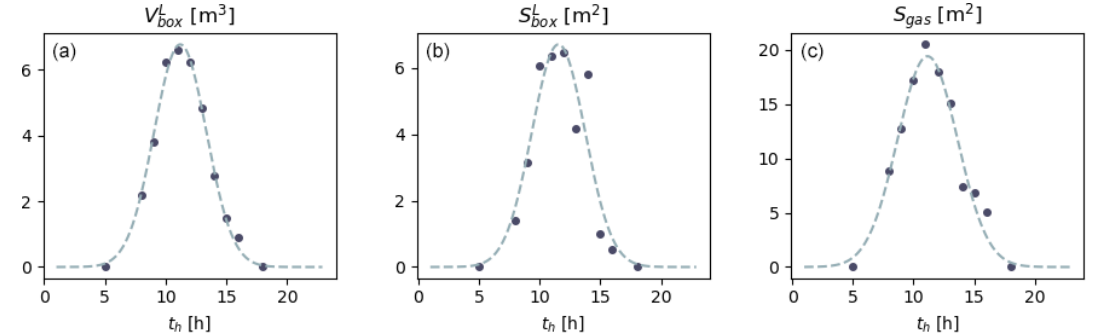
Figure 2. From the left to the right: evolution of (a) V L numerically, and the dashed lines are the Gaussian laws they allow for the inference of. These parameterizations are representative of the time period (27 to 31 October) and location (Martigues, France) of the